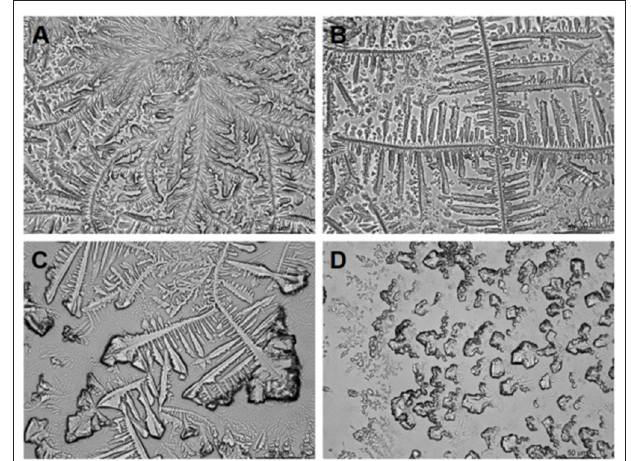
FIGURE 3 | Tear ferning test classification descriptions (Rolando’s classification). Type 1: uniform arborization in the entire field of observation without spaces between the ferns. Single ferns are big and closely branched (A) . Type 2: Arborization is abundant, but the single ferns are smaller and have a lower frequency of branching than in grade 1; empty spaces appear between the ferns (B) . Type 3: Single ferns are little and incompletely formed with rare or no branching (C) . Type 4: No ferning is present; mucus may appear in clusters and threads (D)